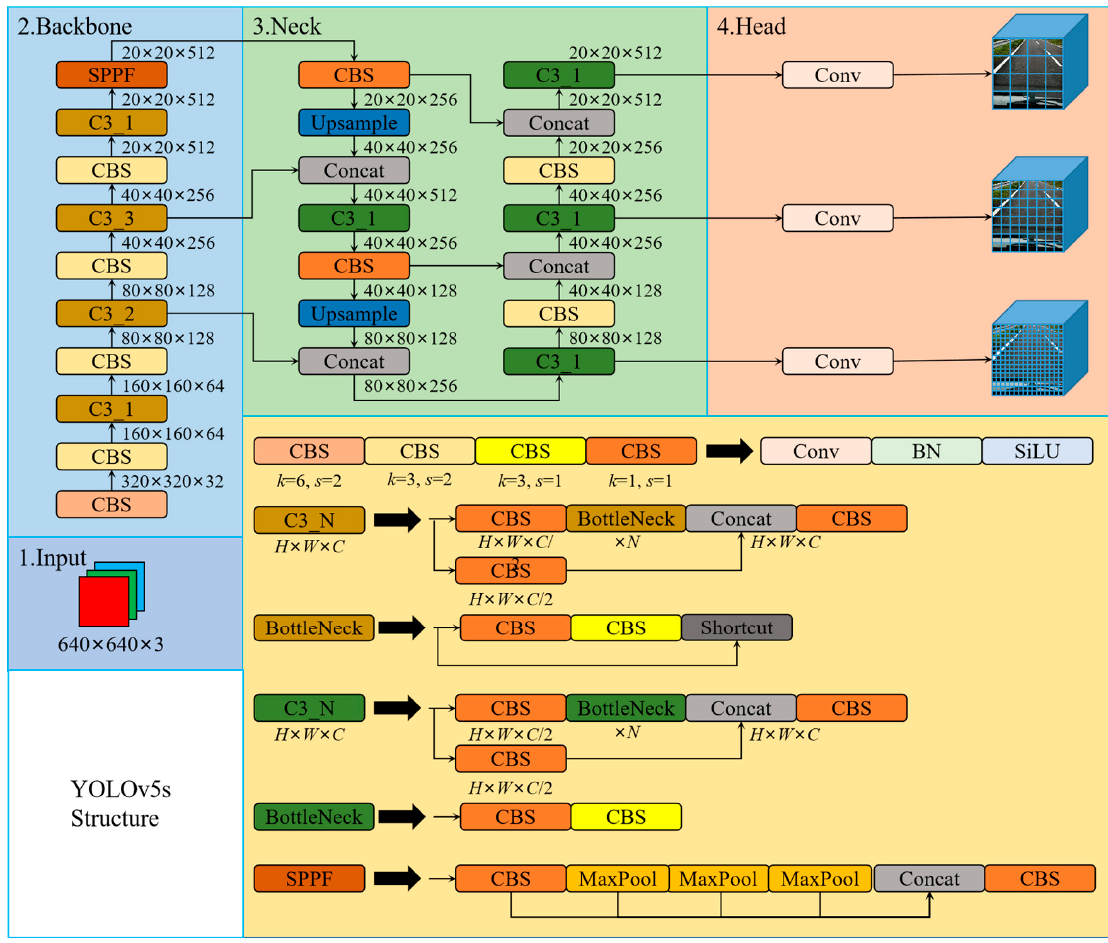
Figure 3. The structure of the YOLOv5-s.